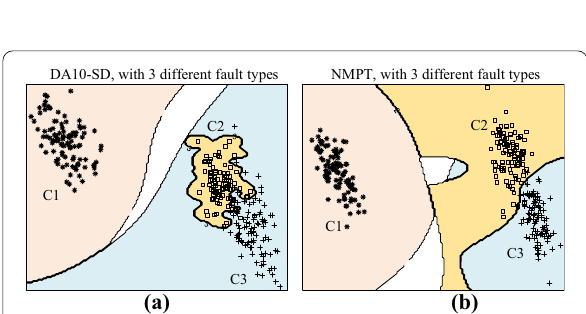
Figure 8 Classification hyperplane of DA10-SD: a Original DA10-SD; b After model parameter transfer